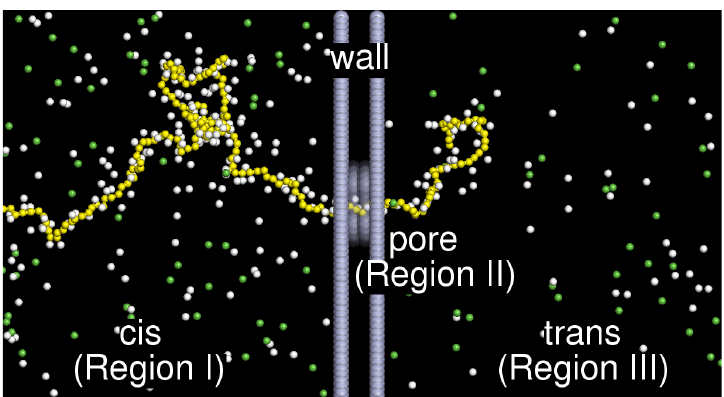
Figure 1. An illustration of the system. The negatively-charged polyelectrolyte is colored in yellow bead-spring chains. The counterions (( + 1)-ions) are represented in white beads, and the coions (( − 1)-ions) are in green beads. A hallow wall separates the space into the cis region (Region I) and the trans region (Region III), connected by a pore channel (Region II) at the center. An electric field (cid:126) E = − E ˆ z is applied inside the pore where the unit vector ˆ z points to the right, along the channel axis. The chain threads through the pore and is gradually transported from the cis region to the trans region by the electric field. In order to visualize the chain section inside the pore, the wall beads (in gray color) have been plotted with a certain degree of